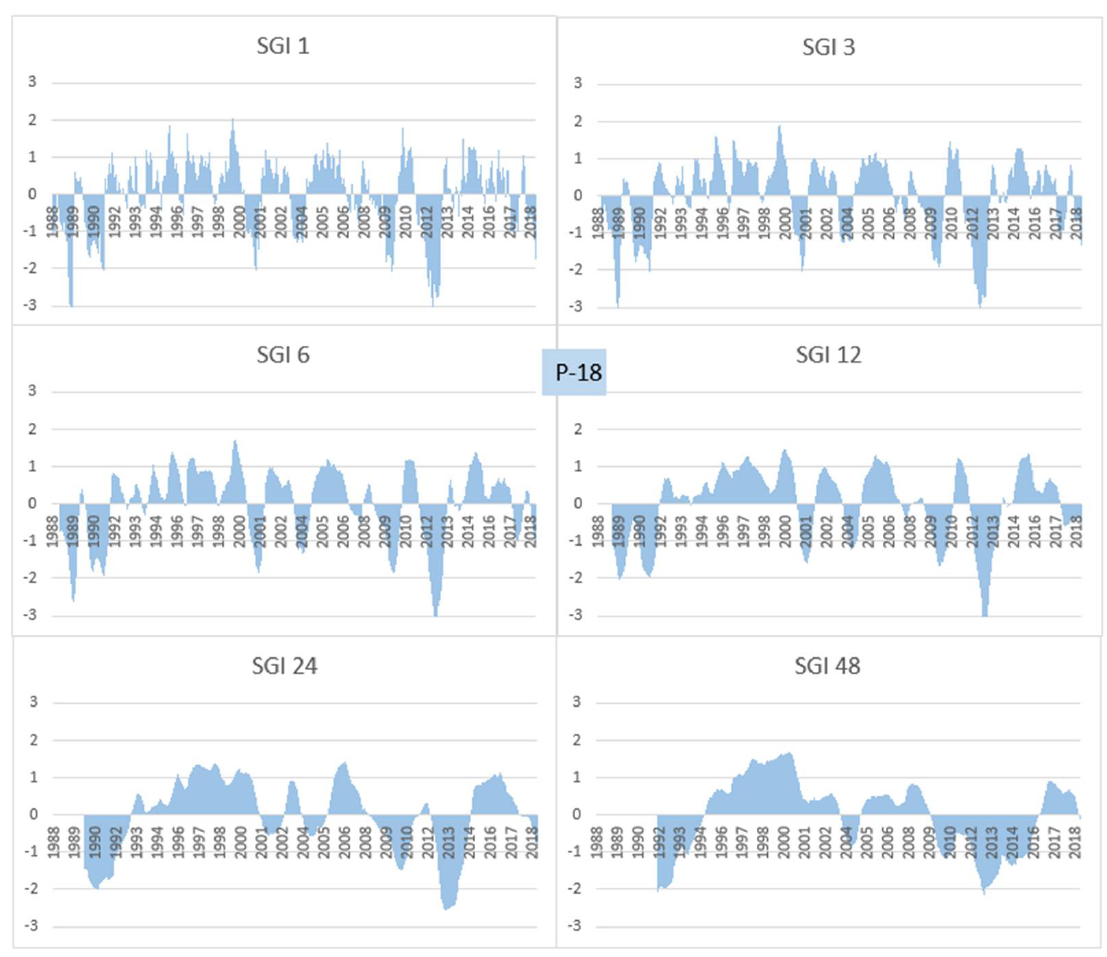
Figure 5. SGI values for 1, 3, 6, 12, 24, and 48 months (observation well P-18).